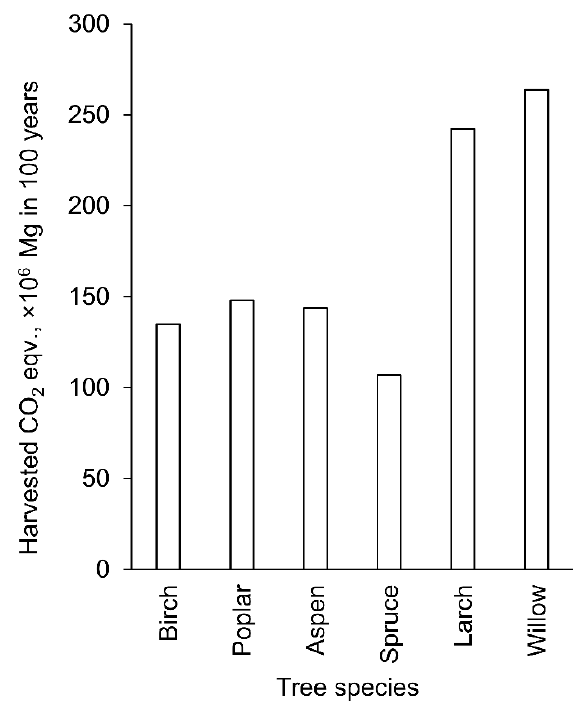
Figure 4. The sum of harvested wood expressed as CO 2 eqv during the 100-year period for different tree species at the landscape level.